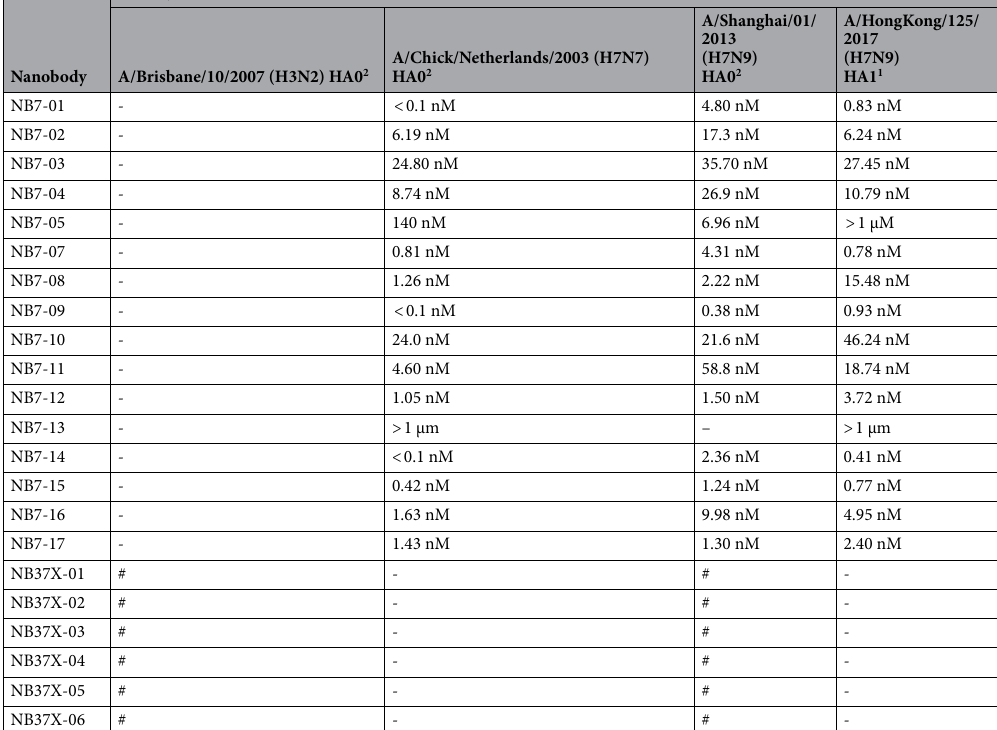
Table 2. Characterisation of nanobody binding affinity and head/stem specificity. 1 HA1 is purified hemagglutinin head domain. 2 HA0 is purified full length hemagglutinin. # binding seen but could not be